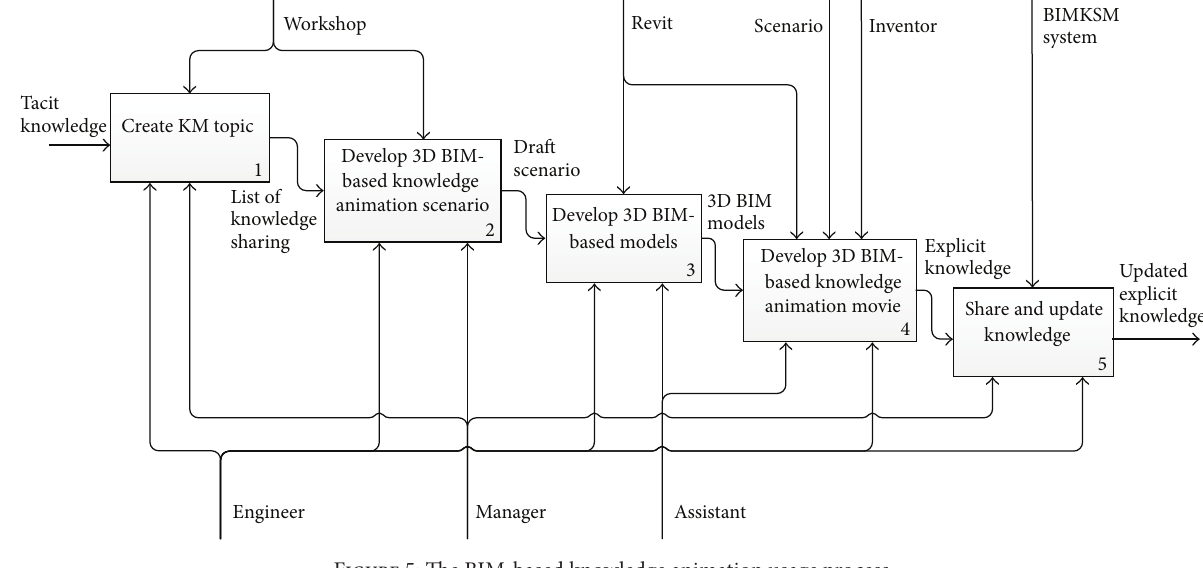
Figure 5: The BIM-based knowledge animation usage process.